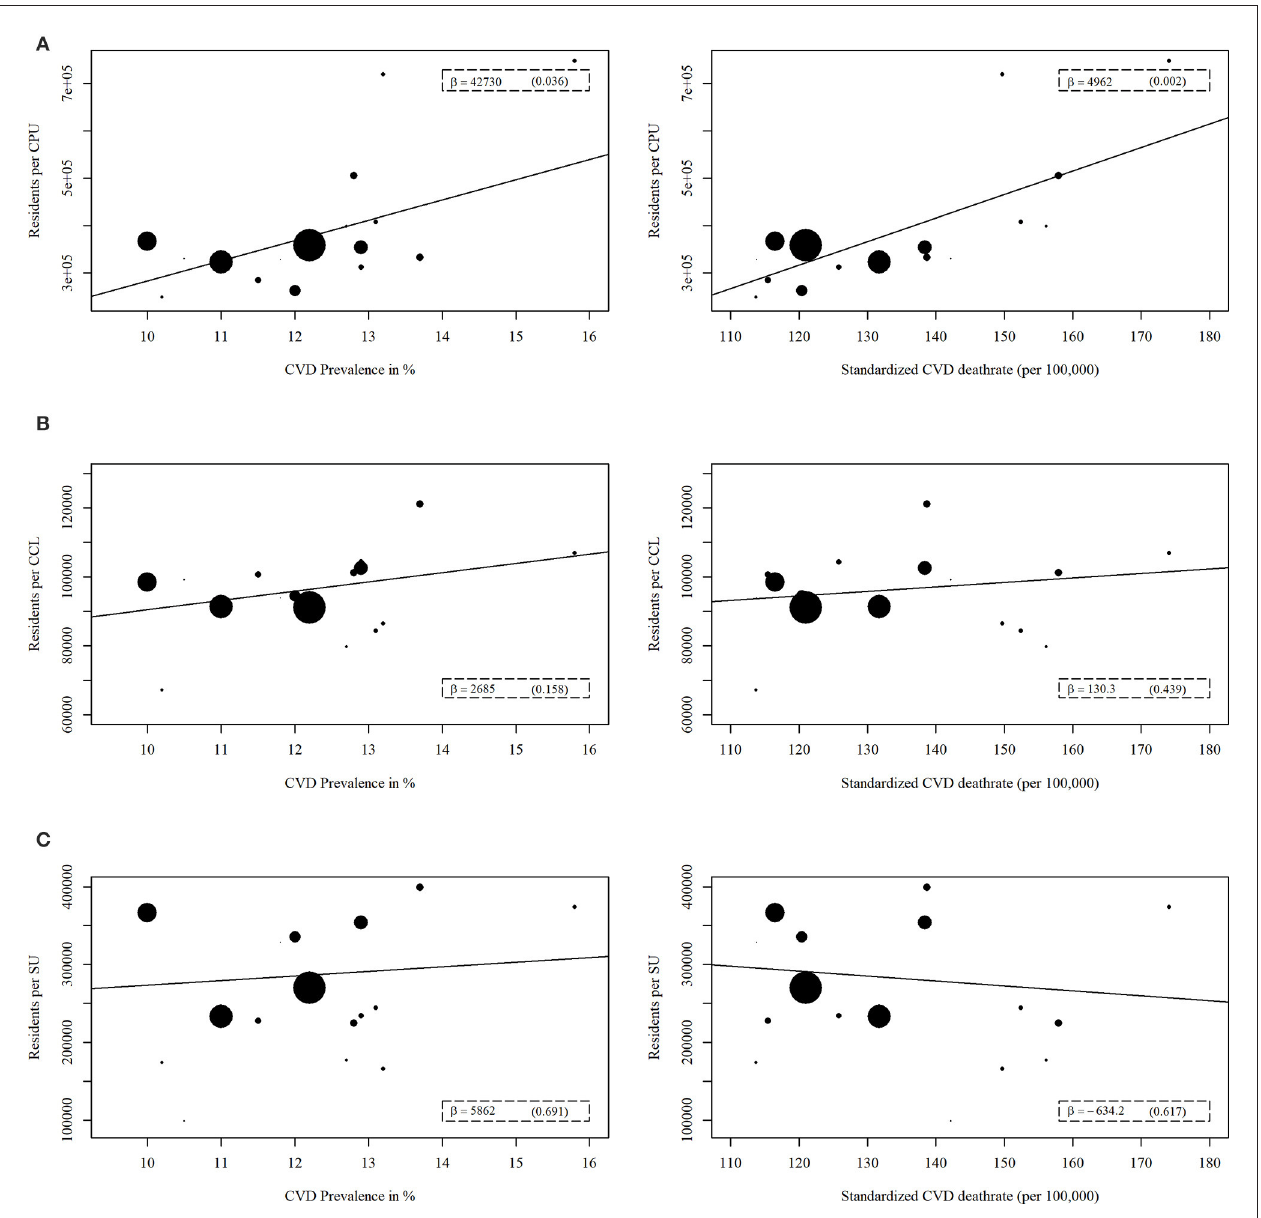
FIGURE 4 | Regression analyses of acute medical care structure indicators with prevalence or mortality of major cardiovascular disease (CVD). The acute medical care structure indicators are (A) Number of residents per chest pain unit (CPU), (B) Number of residents per cardiac catheterization laboratories (CCL), (C) Number of residents per stroke unit (SU). A weighted linear regression was done for every association. The weight refers to the population size of each federal state. The size of the data points reflects the different